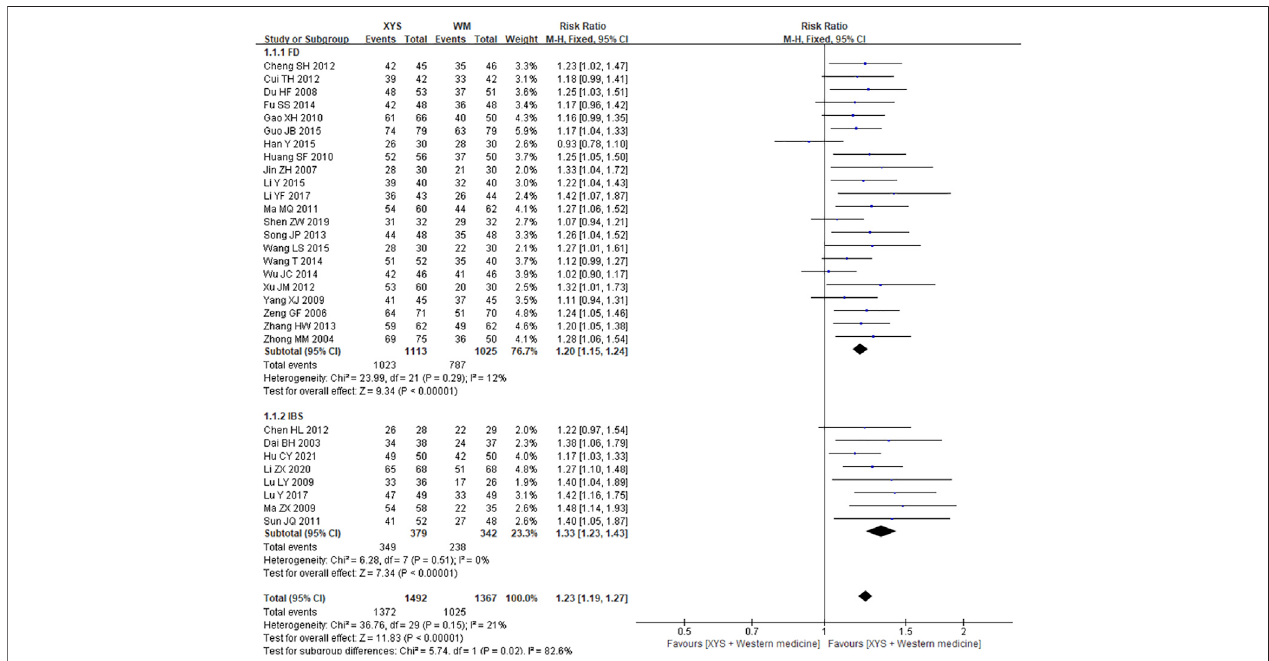
FIGURE 2 | Forest plot of comparison of ef fi cacy: XYS as an adjuvant to western medicine for FGIDs. WM, western medicine.